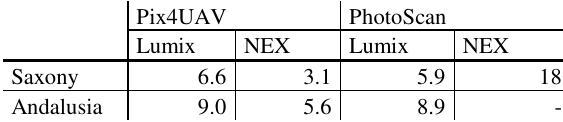
Table 4. Average point deviation [mm] for DTMs from TLS and UAV